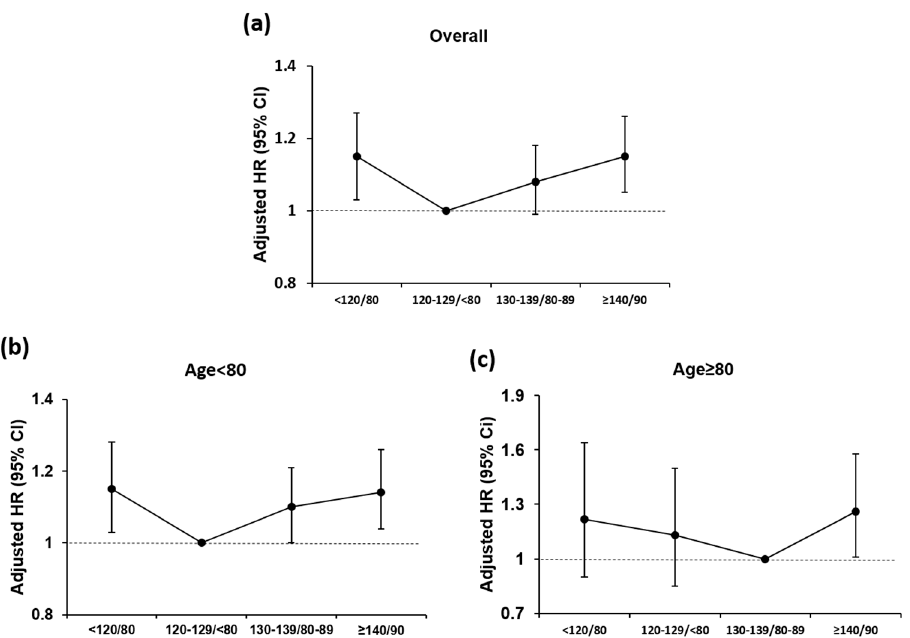
Figure 3. Blood pressure status of repeated measurement and risk of atrial fibrillation among elderly populations: ( a ) overall population, ( b ) age < 80 years, and ( c ) age ≥ 80 years. HR, hazard ratio.